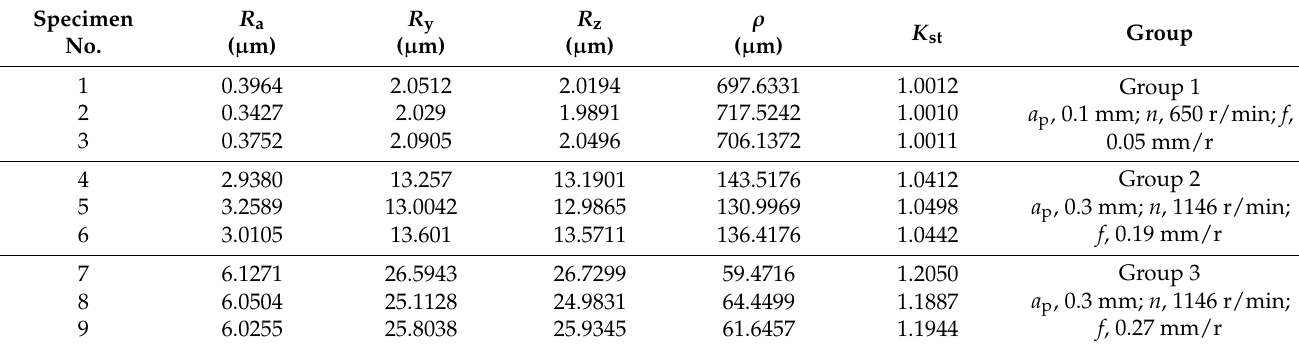
Table 3. The processing parameter sets correspond to different target